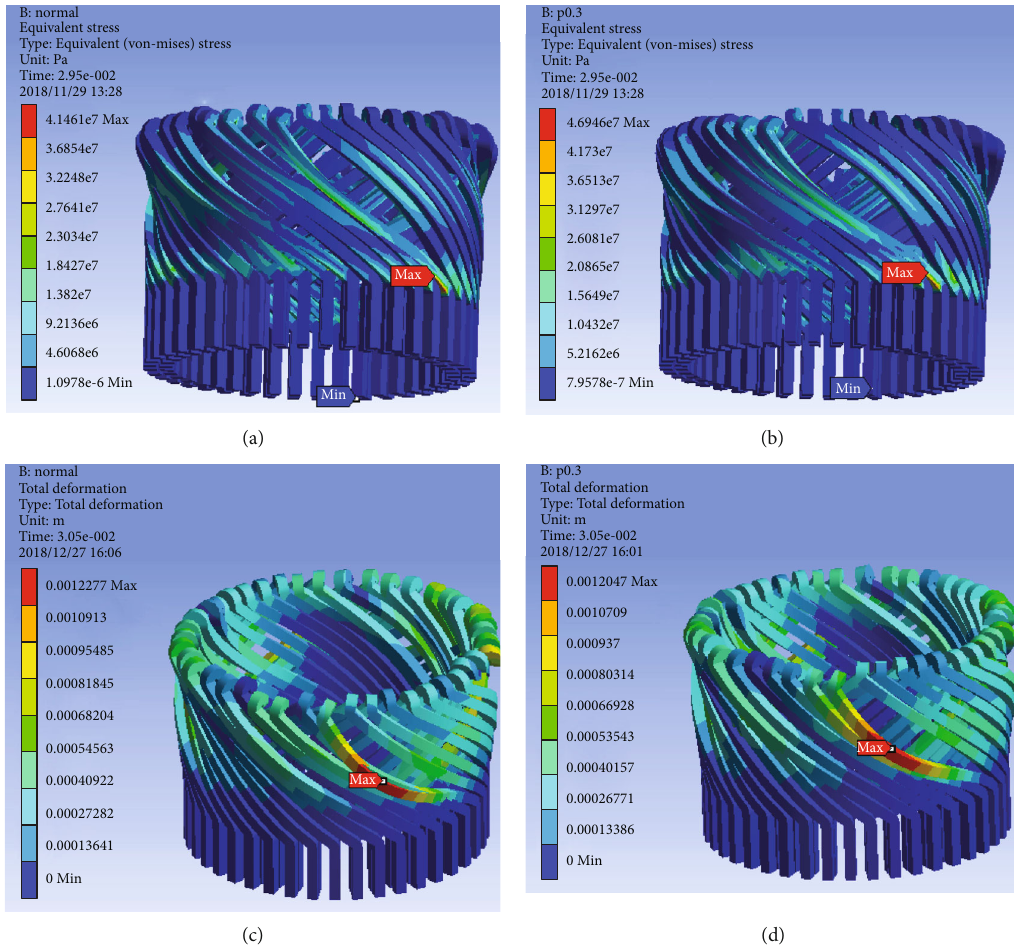
Figure 7: Mechanical response: (a, b) stress and (c, d) deformation in normal and eccentricity condition,